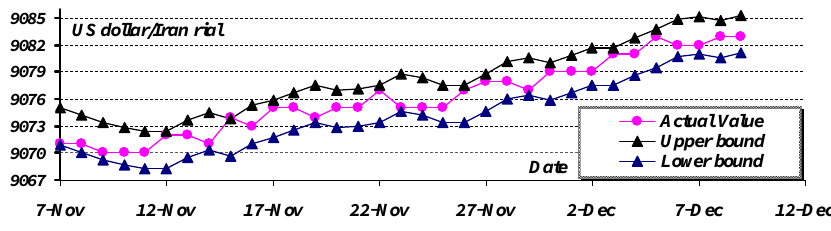
Fig. 5 Upper and lower bounds obtained for US dollar against Iran rial.